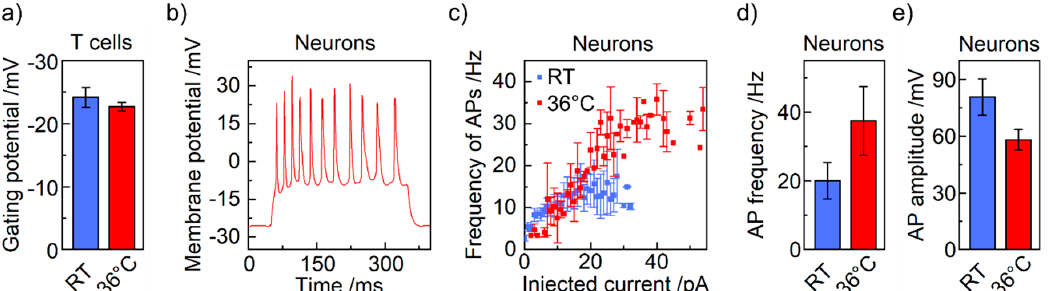
Figure 5. Specific electrophysiological properties. ( a ) Gating threshold of voltage-gated ion channels in T cells at RT and 36 °C. ( b ) Exemplary patch clamp recording of action potentials (APs) at 36 °C during current injection from 50 to 350 ms. ( c ) The firing frequency of APs depending on the injected current for RT and 36 °C of specific cells. The error bars are standard deviation. ( d ) Average maximal firing frequency of action potentials at RT and 36 °C weighted of n cells. ( e ) Average height of APs at maximal firing frequency at RT and 36 °C. T cells: n (RT) = 11, n (36 °C) = 7. Neurons: n (RT) = 8, n (36 °C) = 7.